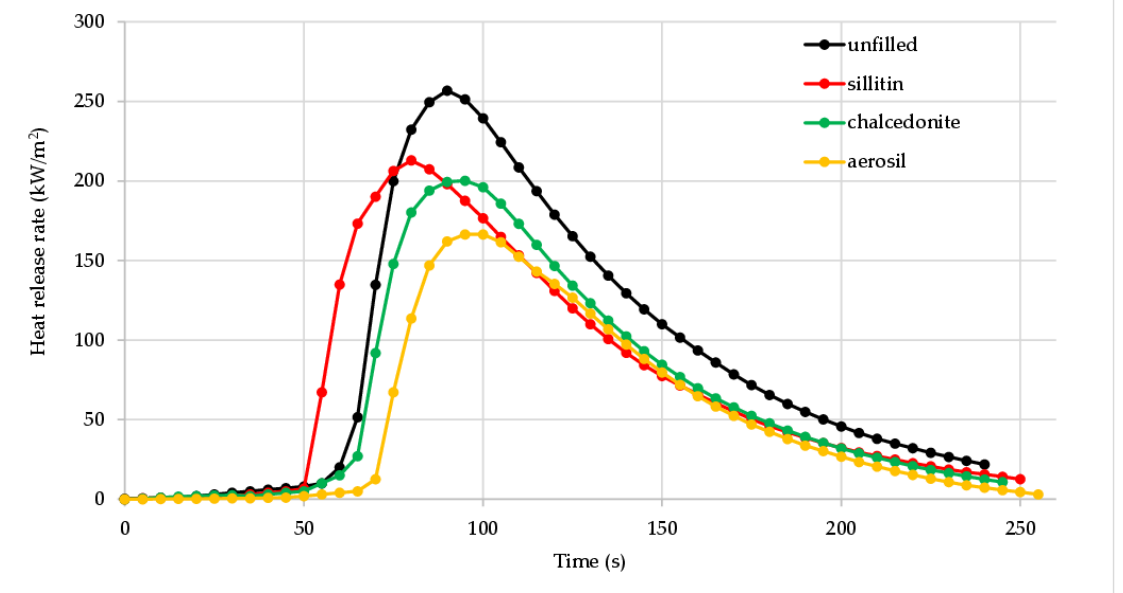
Figure 4. Heat release rate (HRR) of unfilled or filled vulcanizates.